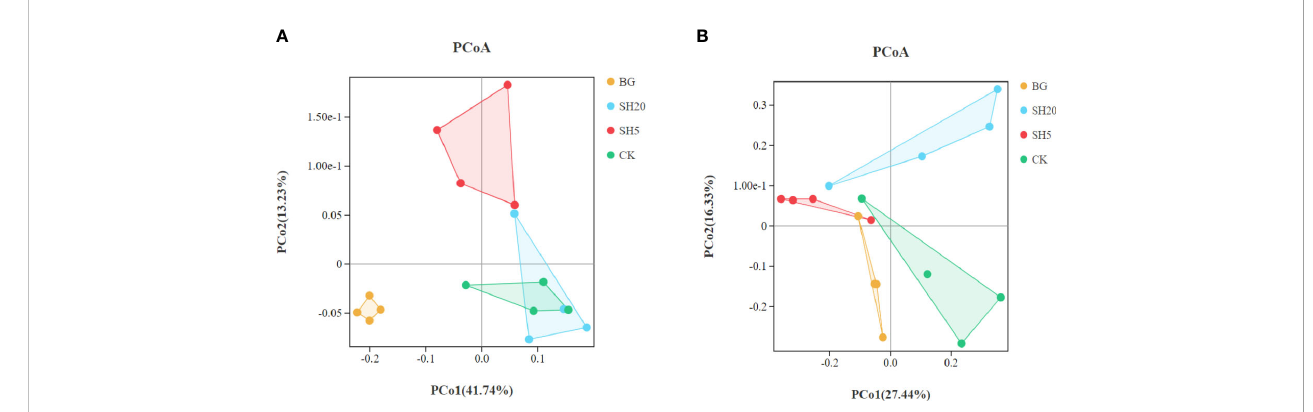
FIGURE 5 Principal coordinates analysis (PCoA) of the bacterial (A) and fungal communities (B) at the operational taxonomic unit (OTU) level based on Bray-Curtis